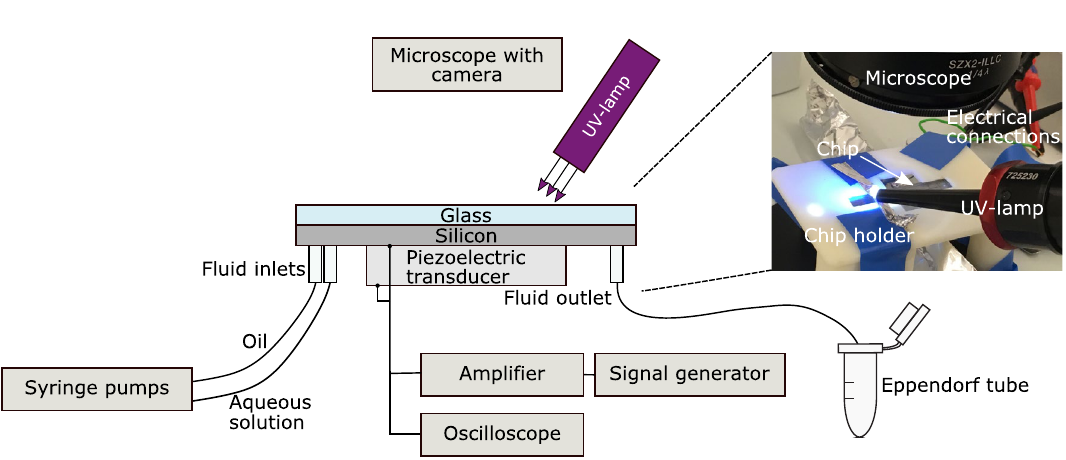
Figure 7. Illustration of the experimental setup. The inset shows the position of the UV-lamp and the